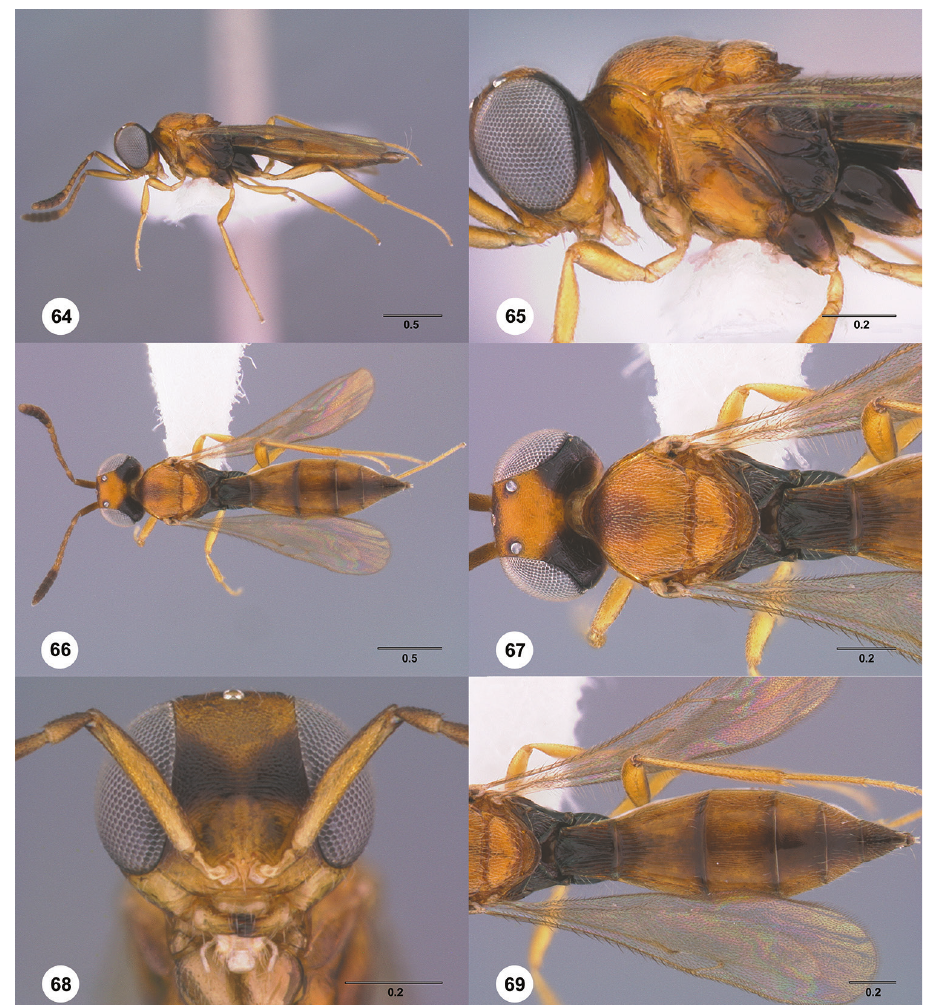
Figures 64–69. Calliscelio brevinotaulus sp. n., female, holotype (OSUC 190678). 64 Lateral habitus 65 Head and mesosoma, lateral view 66 Dorsal habitus 67 Head and mesosoma, dorsal view 68 Head, anterior view 69 Metasoma, dorsal view. Scale bars in millimeters. tween notauli: smaller than those along margin of axilla. Sculpture of mesoscutellum: granulate. Shape of metascutellum: posterior margin rounded, 2.5× wider than long. Sculpture of metascutellum in female: rugose. Sculpture of metascutellum in male: ru- gose. Dorsal propodeum in female: shallowly excavate medially, with lateral propodeal carinae widely separated. Sculpture of dorsal propodeum in female: rugose. Sculpture of dorsal propodeum in male: rugose with one or two longitudinal keels lateral to median keel. Median keels on propodeum in female: absent. Mesopleural carina: ab- sent. Sculpture of mesepisternum below mesopleural depression: smooth.